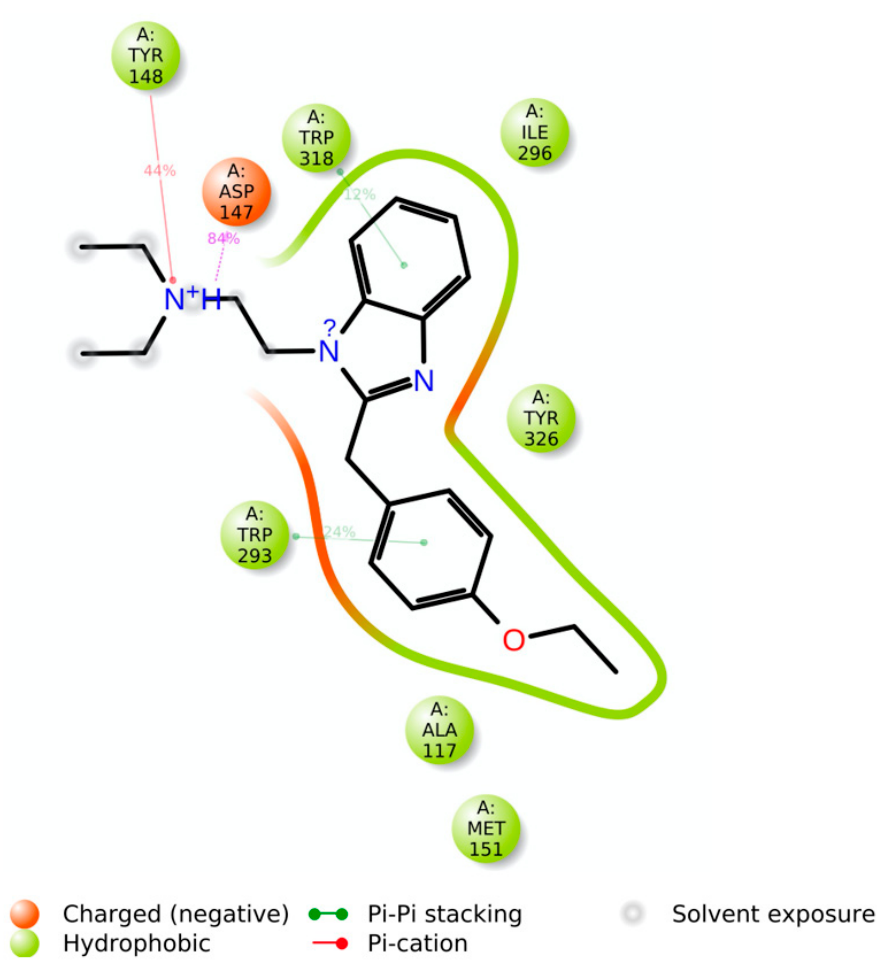
Figure 8. 2D interaction diagram showing detailed etazene–atom interactions with key protein residues during the 200-ns MD simulation.